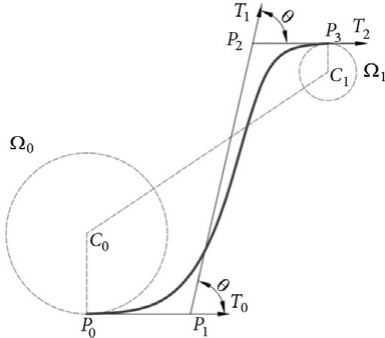
Fig. 6. Schema of S -shaped joining of the circular arcs using a cubic C -Bezier curve